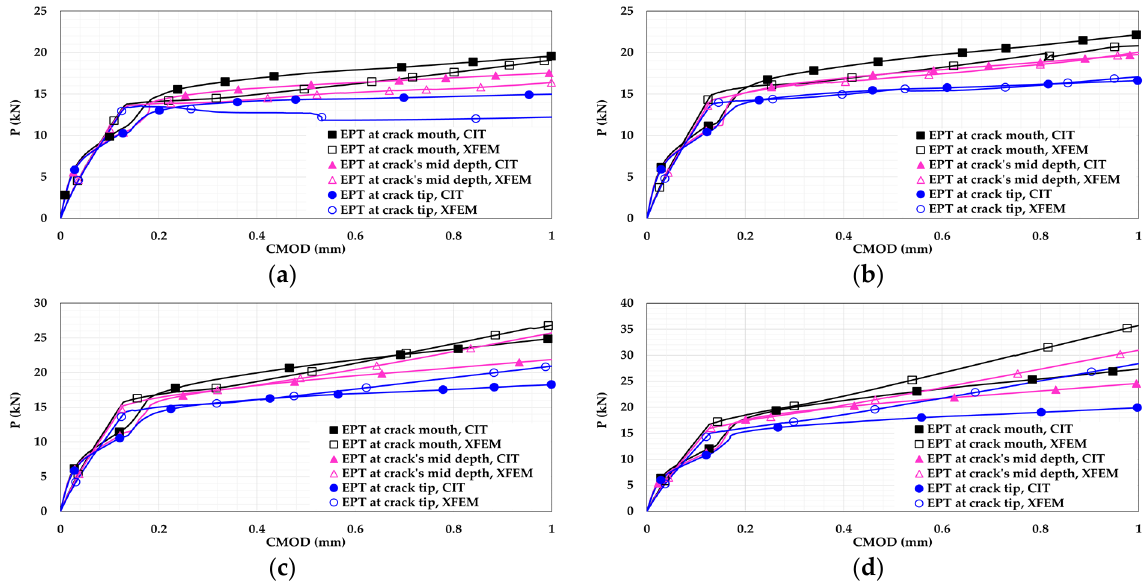
Figure 13. Reinforced concrete beam P-CMOD relationships for different EPTs at different locations: ( a ) 0%; ( b ) 25%; ( c ) 50%; ( d ) 75%.